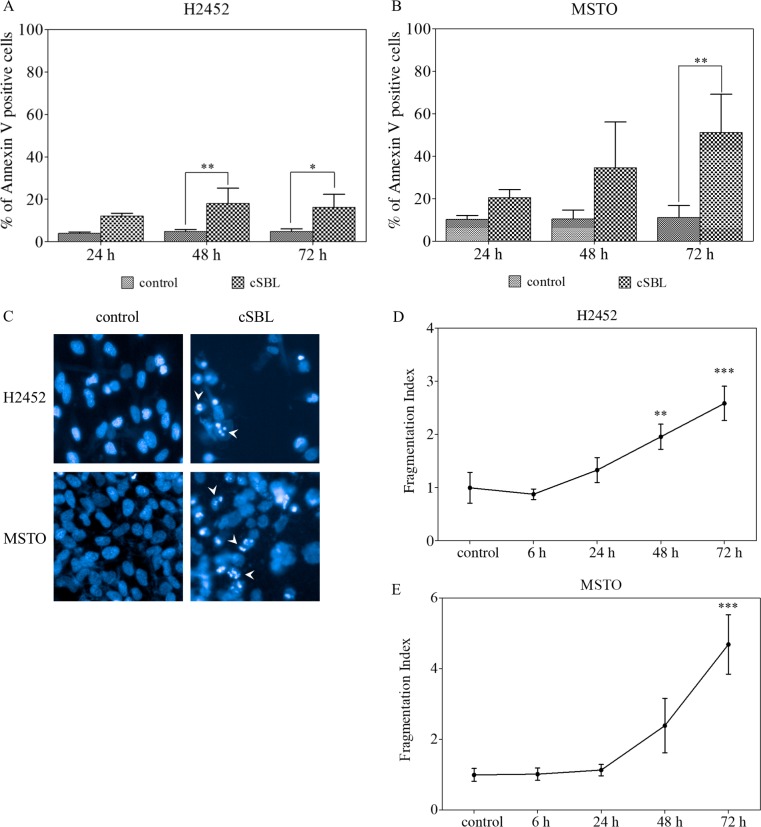
cSBL induced apoptotic changes in H2452 and MSTO cells.Cells were treated with cSBL for the indicated times. (A, B) Rate of apoptosis as indicated by the percentage of annexin V-positive cells. (C) Nuclear fragmentation images were captured using 40X objective; a false-colored image of the nuclei (blue) is shown. White arrowheads indicate the cells with condensed or fragmented nuclei. (D, E) Fragmentation index indicating the degree of nuclear fragmentation; a higher index indicates greater occurrence of fragmentation, calculated using the High-Content Analysis System. All data are expressed as the mean ± SD of three independent experiments. The statistical significance of these experiments compared with the control is shown as follows: *P<0.05, **P<0.01, ***P<0.001.